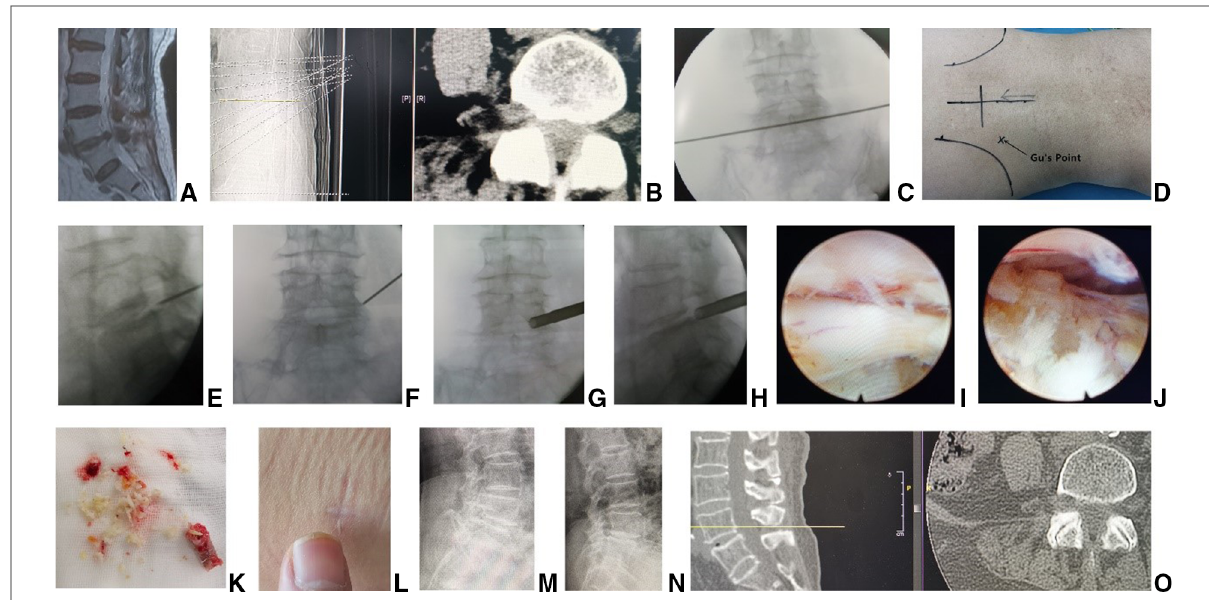
FIGURE 1 Female patient of 89 seats with LDD aL4 5 had bilateral asymmetric leg pain and the right side is more seven preoperative ( A ) sagittal MR and ( B ) CT images showed L4/5 disc herniation, lateral recess stenosis and neurologic compression. The procedure of PIES was undertaken for the patient. A transverse line bisecting the disc was draw along the metal rod which was placed transversely across the center of the target disc on ( C ) posteoanterior C-arm view. ( D ) Photography showed the surface marking of anatomic disc center identi fi ed by the intersection of transve: line and longitudinal midline, which was the aiming reference point of puncture, and the entrance point of puncture (Gu ’ s point) located at the corner of fl at back turning to lateral side. During puncture, once resistance disappeared, the C-arm view was taken to ensure that the tip of puncture needle was in the intracanal area clot to the posterior wall of disc on ( E ) lateral x-ray and near the lateral border of pedicle on ( F ) posteoanterior x-ray. During press down enlargement of foramen, when resistance disappeared, the tip of reamer should exceed the medial border of pedicle on ( G ) posteroanterior C-arm view and reach clot to the posterior wall of target disc on ( H ) lateral C-arm view. Under ( I,J ) endoscopic view, the bilateral compressed nerve roots were freed after ( K ) the hypertrophic ligamentum fl avum and herniated disc were removed. ( L ) The picture showed the mini incision for PIES 2 years after surgery. No new lumbar instability was found on postoperative ( M ) hyperextension and ( N ) hyper fl exion lateral x-ray image. ( O ) CT images showed the resected articular process and enlargement of L4/5 right